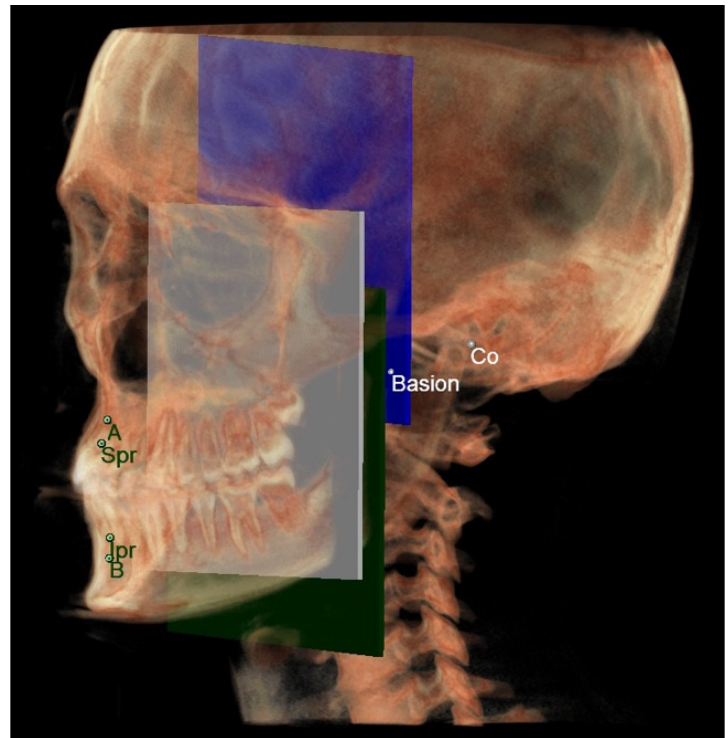
Figure 11. All the planes and points of the 3D horizontal